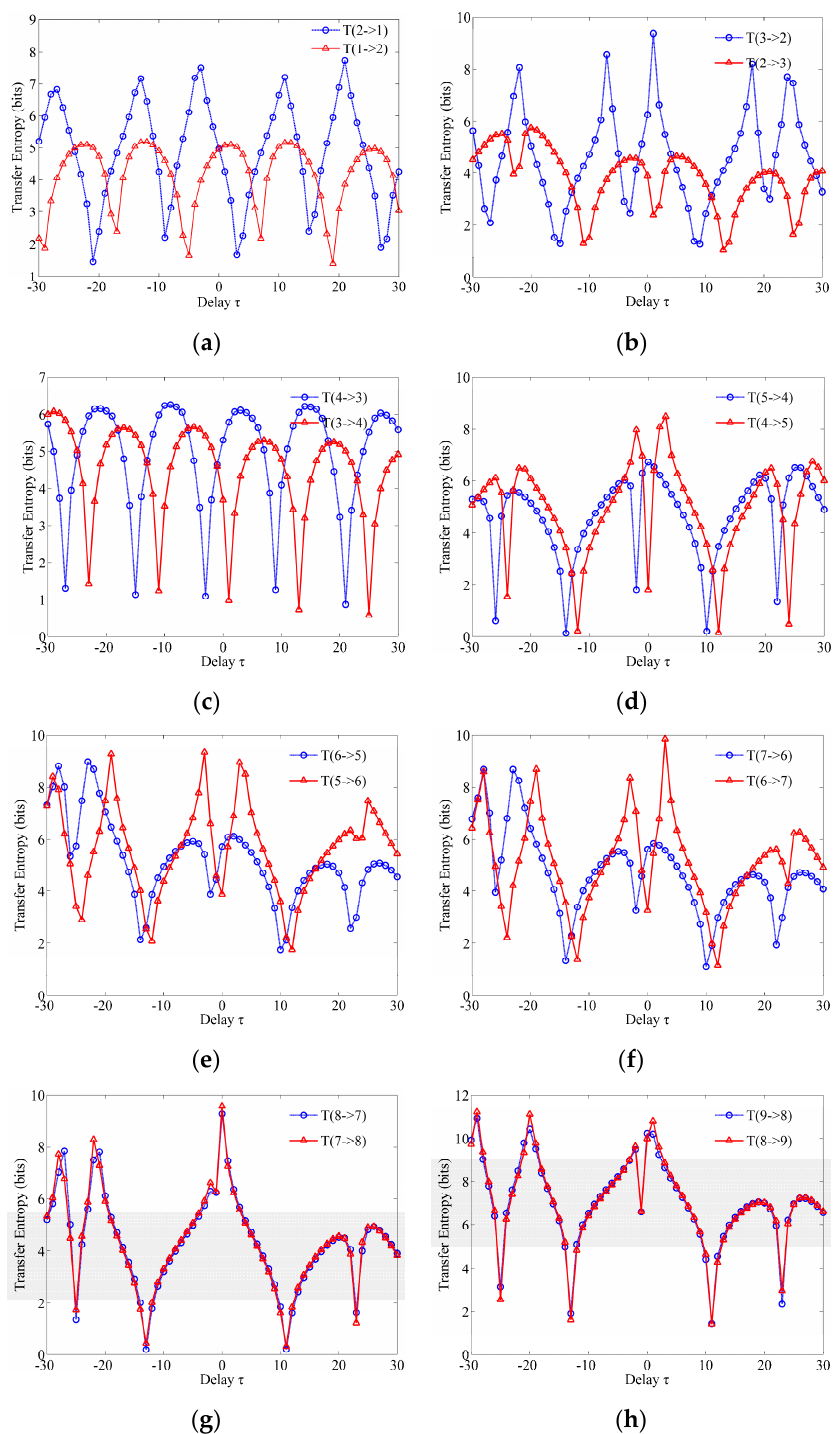
Figure 14. Time-delayed transfer entropy curve of the frequency of 18.75 Hz fluid pressure pulsation. Transfer entropy between measuring points F01 and F02 ( a ), F02 and F03 ( b ), F03 and F04 ( c ), F04 and F05 ( d ), F05 and F06 ( e ), F06 and F07 ( f ), F07 and F08 ( g ), and F08 and F09 ( h ).